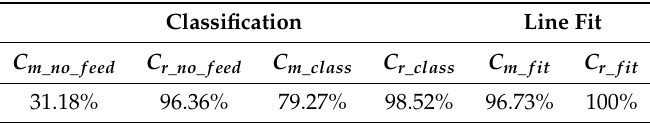
Table 2. Point classification performance.